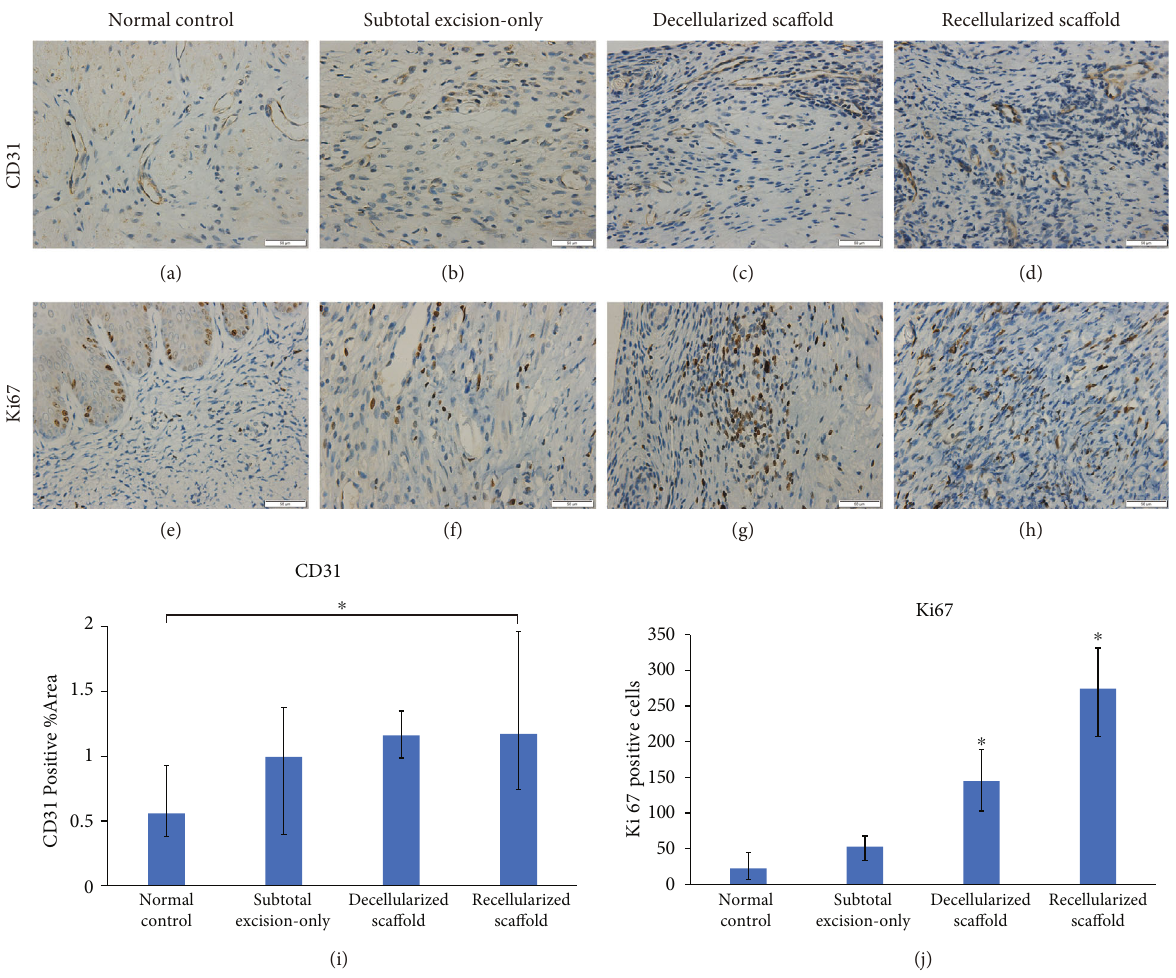
Figure 6: Immunohistochemistry of reconstruction of partial uterine cervical defect in rat. Immunostaining of CD31 (a – d) and Ki67 (e – h), respectively, in normal control (a, e), subtotal excision-only (b, d), decellularized sca ff old (c, e), and recellularized sca ff old (d, h) groups. Scale bars represent 50 μ m. The CD31 positive neovascular area of the recellularized sca ff old group was signi fi cantly higher than that of the normal control group (i). The normal control group was the lowest in Ki67-positive expression with a higher concentration of positive-stained cells in the luminal epithelium. The sca ff old groups were all signi fi cantly higher than the other two groups, with the recellularized sca ff old group being the highest. ∗ P < 0 : 05